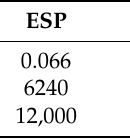
Table 5. Operating parameters of BEP, NSP, ESP.